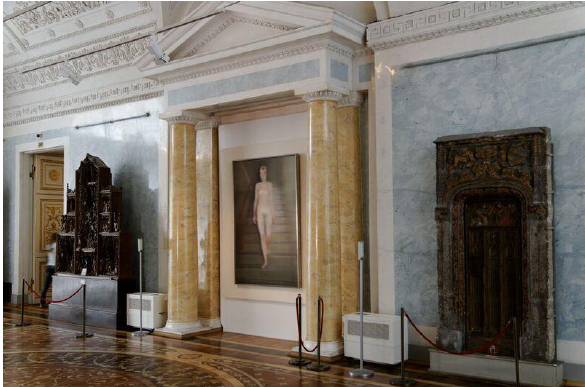
Figure 8 | Gerhard Richter, Ema, Nude on a Staircase (1966). Oil on canvas, 200 x 130 cm. Museum Ludwig (ML 01116, Cologne). Installation view, MANIFESTA 10, Winter Palace, State Hermitage